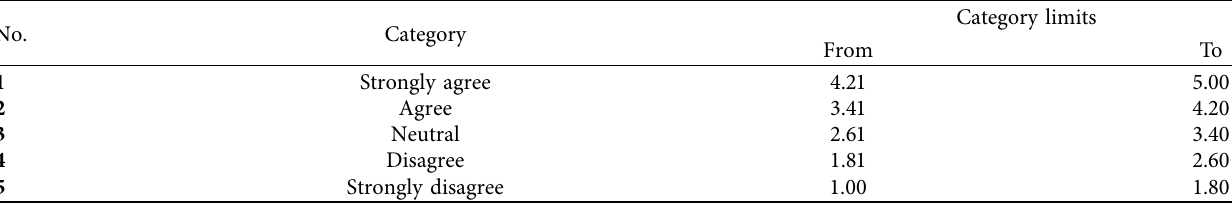
Table 2: Division of the five-point Likert scale categories (limits of average responses).